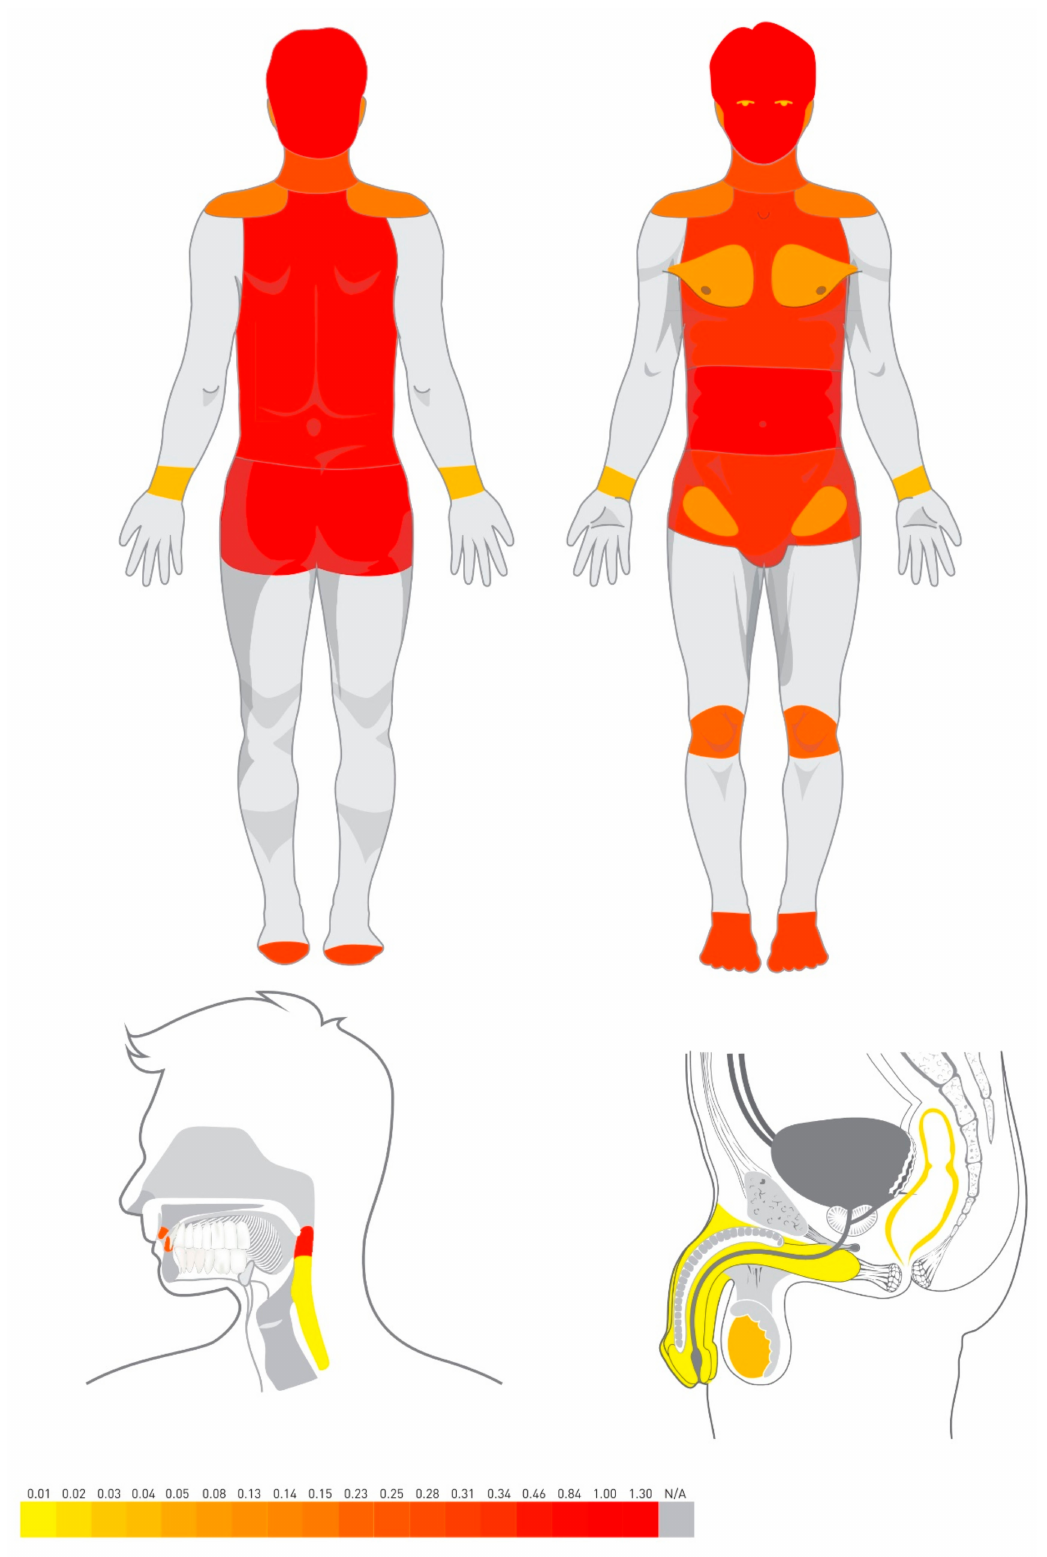
Figure 1. Visualization of the worldwide relative search volume of pain-related topics